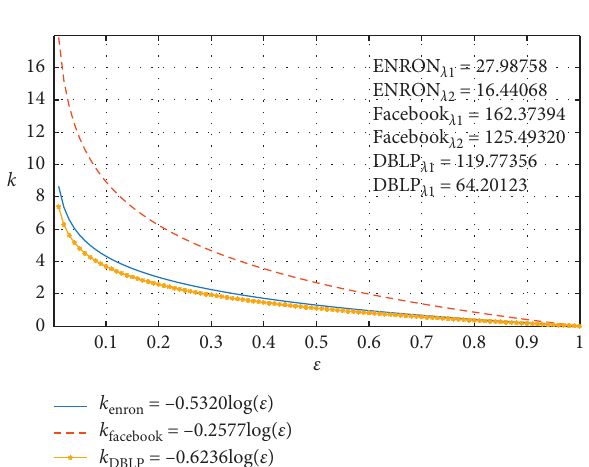
Figure 21: l − 1 comparison result of iteration